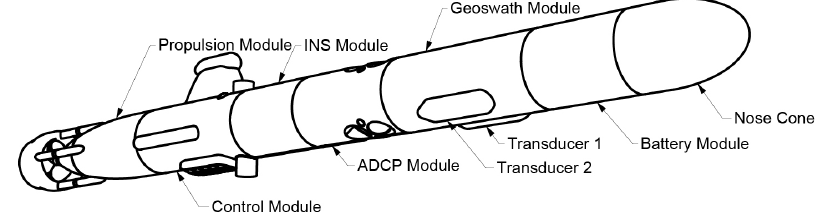
Figure 2. The specification of the Gavia AUV with the Geoswath Plus module and transducer configuration.